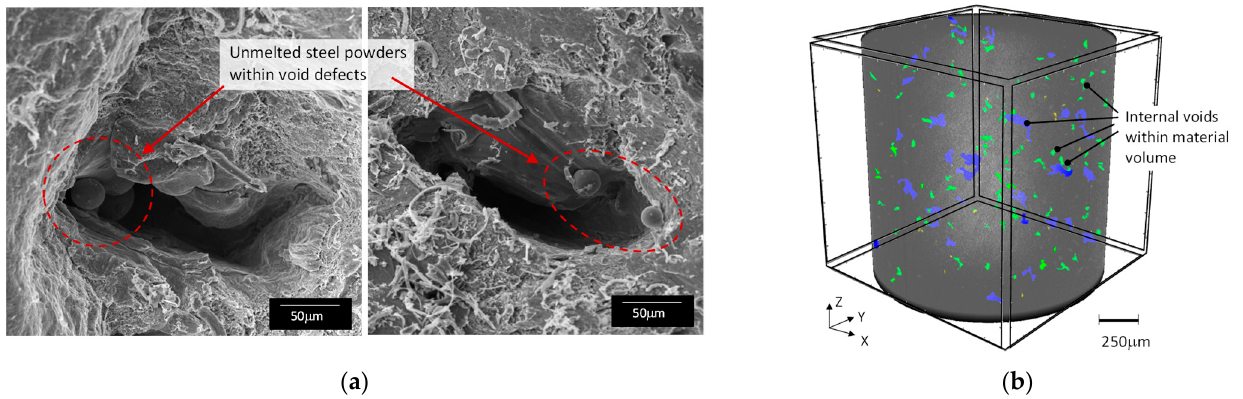
Figure 7. Voids due to un-melted metal powder in an AM-AB specimen: ( a ) SEM fractograph, and ( b ) CT scan of unstrained (grip location).